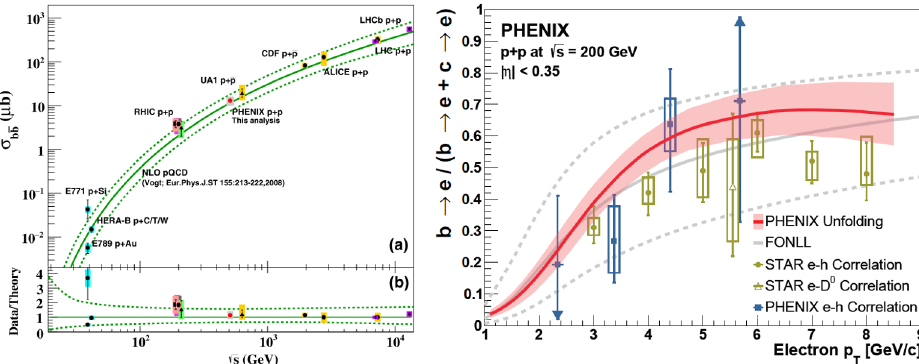
√ s [14] compared to NLO pQCD